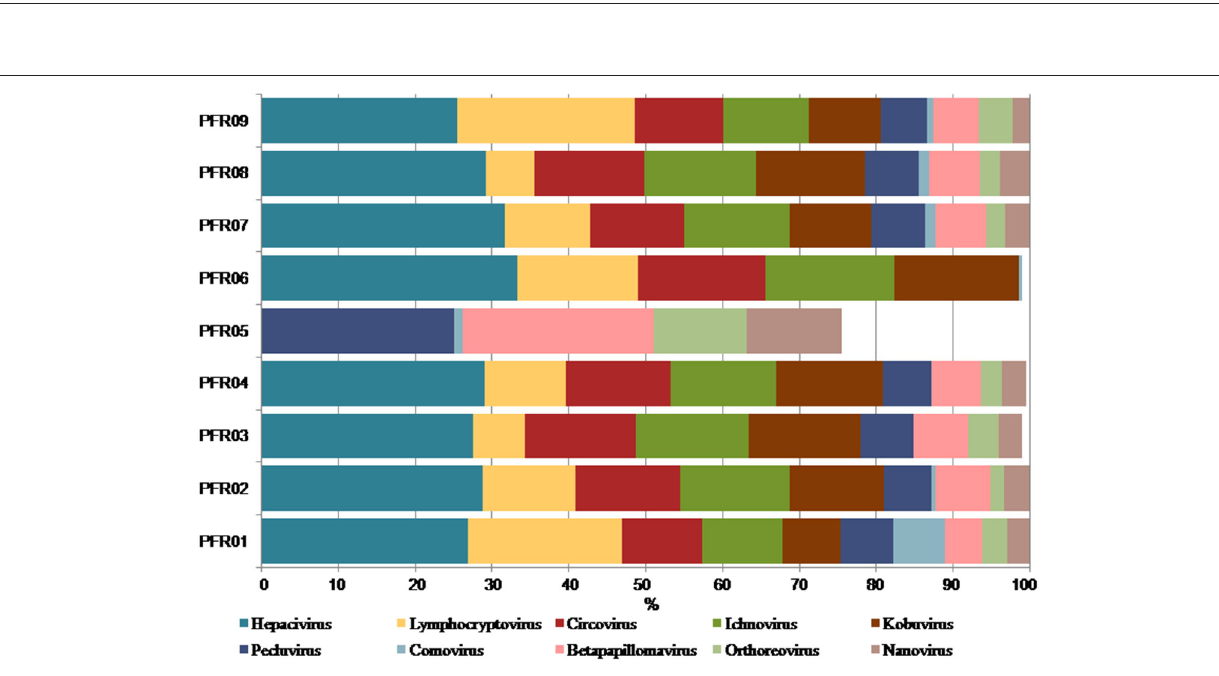
Frontiers in Medicine |